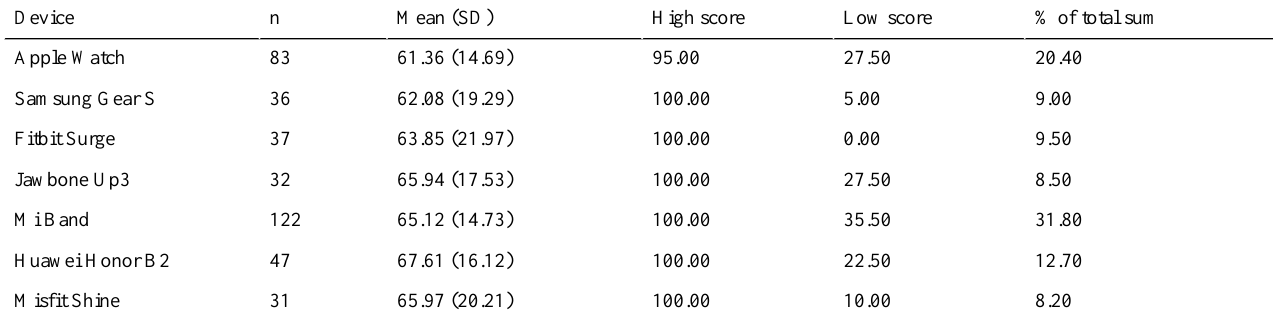
Table 4. Total System Usability Scale (SUS) score of each device (N=388).